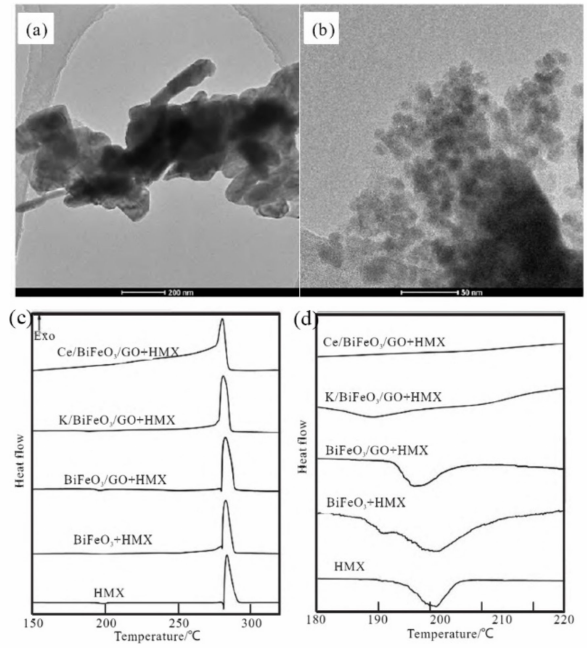
Figure 23. TEM images of ( a , b ) K doped BiFeO 3 /GO and Ce doped BiFeO 3 /GO; DSC curves of ( c , d ) HMX and the mixtures of HMX with four different BiFeO 3 composites. ( a – d ) Reproduced with the permission of ref. [107]. Copyright 2022, Journal of Solid Rocket